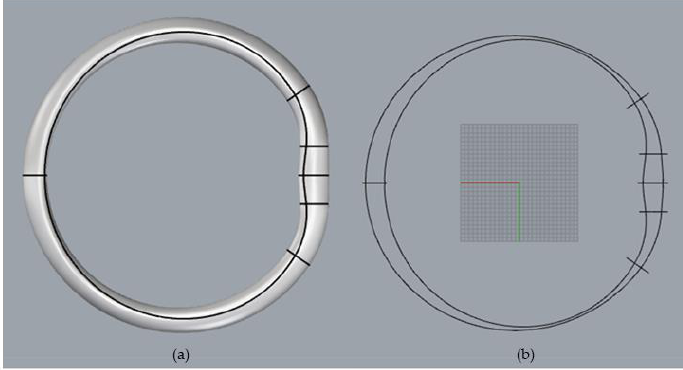
Figure 1. Design process: ( a ) 3D model of the steering wheel, ( b ) 2D model.